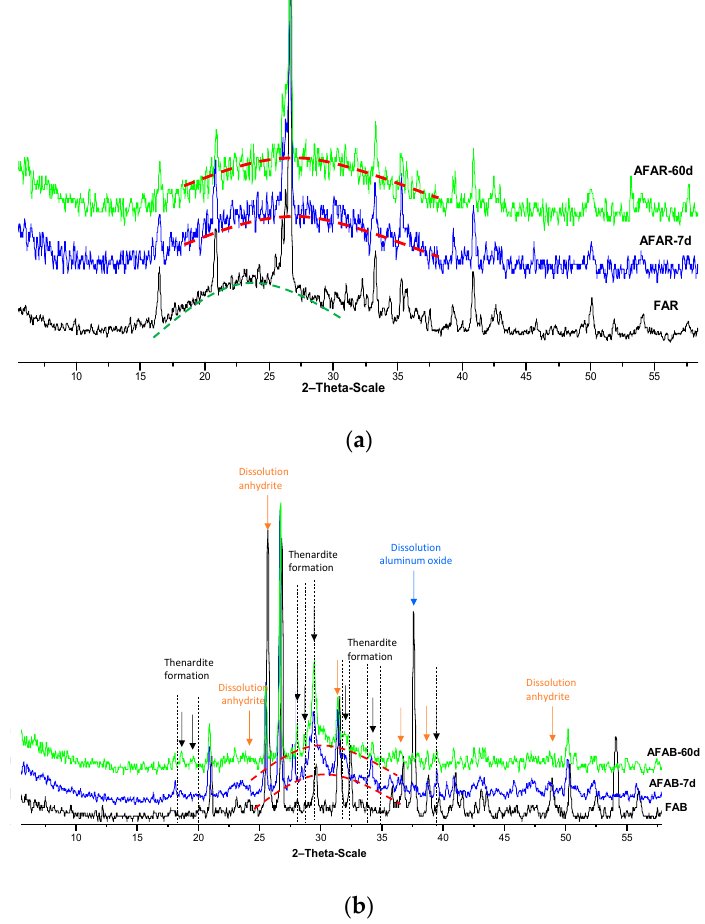
Figure 6. X Ray diffraction pattern of raw and alkali activated fly ash as function of curing times: ( a ) AFAR; ( b ) AFAB.